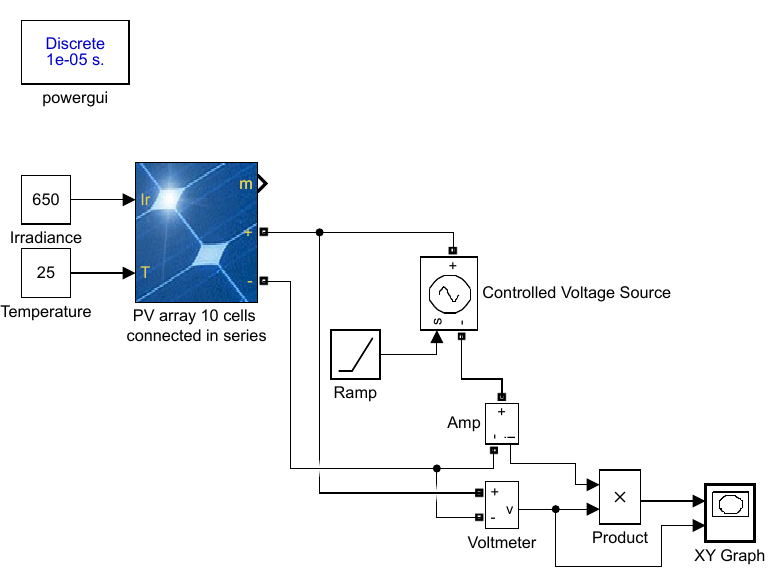
Figure 8. Output power with respect to output voltage during irradiance changes (100% irradiance corresponds to 1000 W/m 2 ).